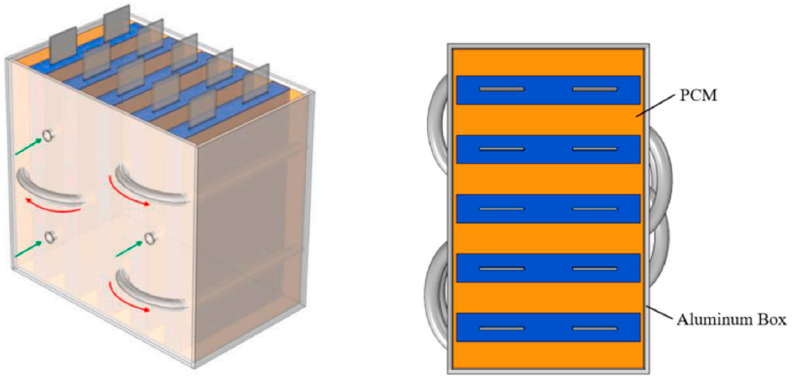
with permission from Elsevier B.V., copyright 2021.